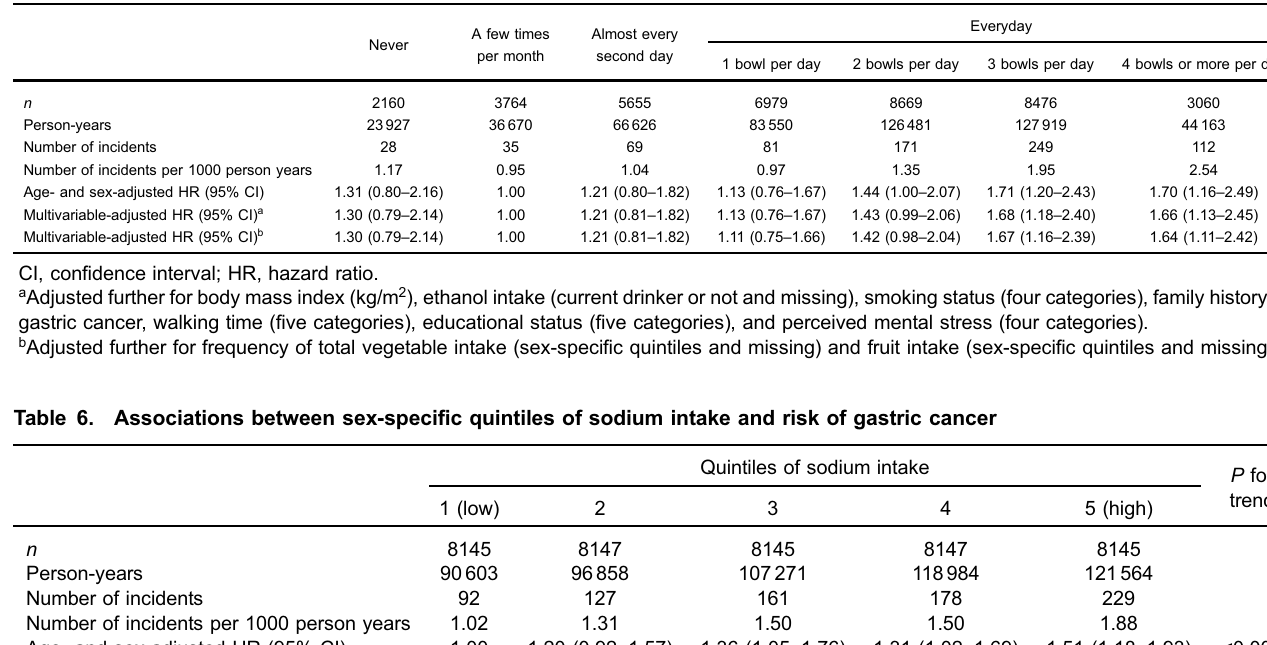
Table 5. Age- and sex-adjusted and multivariable-adjusted hazard ratios of gastric cancer according to frequency of miso soup intake